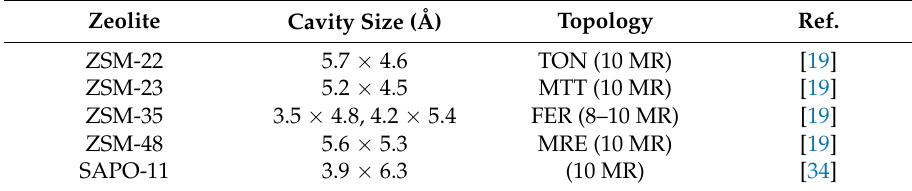
Table 2. Cavity sizes and topology of zeolites exhibiting shape selectivity in hydroisomerization of long-chain alkanes. MR denotes membered ring channels in